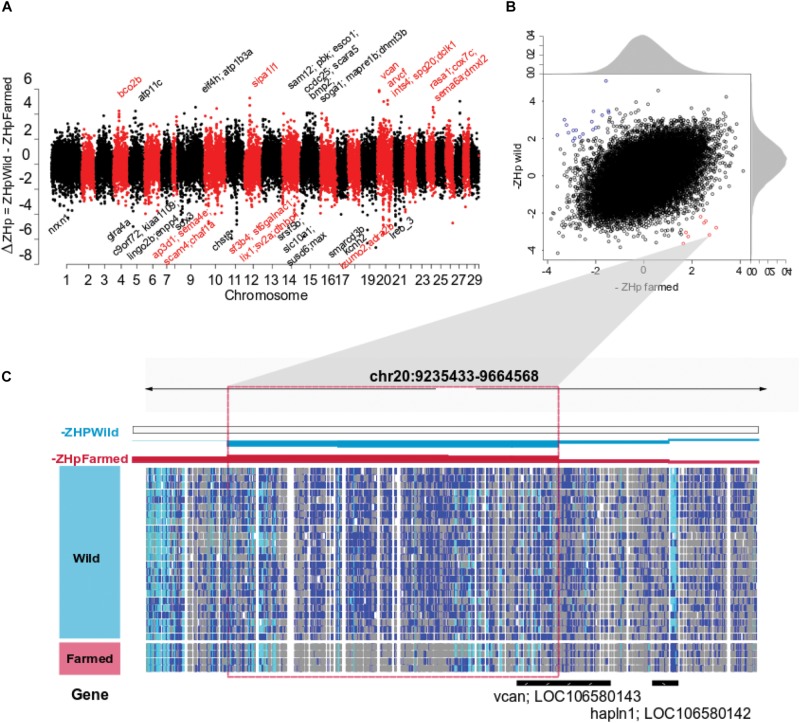
Selective sweep analysis for Dataset 1. (A) Genome wide distribution of ΔZHp derived using both farmed and wild fish. Positive values indicate regions putatively under positive selection in farmed animals. (B) The –ZHp value for each genomic window was plotted for both farmed (x axis) and wild populations (y axis) to show their correlation (r2 = 0.457) and outlier behavior. Windows indicated in red have elevated homozygosity in farmed Atlantic salmon pools compared to wild (p-val ≤ 0.05) while windows indicated in blue are the opposite (p-val ≤ 0.05). (C) A 430 kb region of Atlantic salmon chromosome 20 is shown spanning two windows exhibiting the highest positive ΔZHp values detected genome wide (5.79 and 5.89, Table 2). Genotypic status is shown as separate horizontal tracts for 20 pools of wild fish and 4 pools of farmed fish using the integrated genome viewer (IGV). SNP polymorphism within a pooled sample is indicated using dark blue. SNP homozygosity within a pool is indicated using either gray (where the fixed allele was the same as the reference genome) or cyan (where the fixed allele was the non-reference allele).